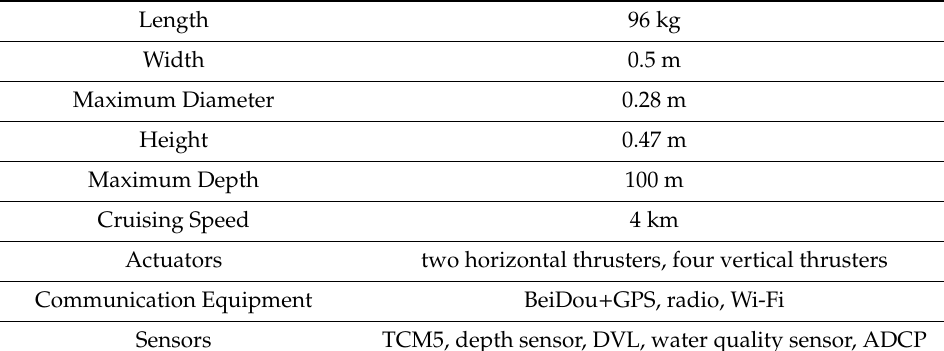
Figure 1. Plateau data-gathering AUV (autonomous underwater vehicle). Table 1. Key specifications of the AUV.